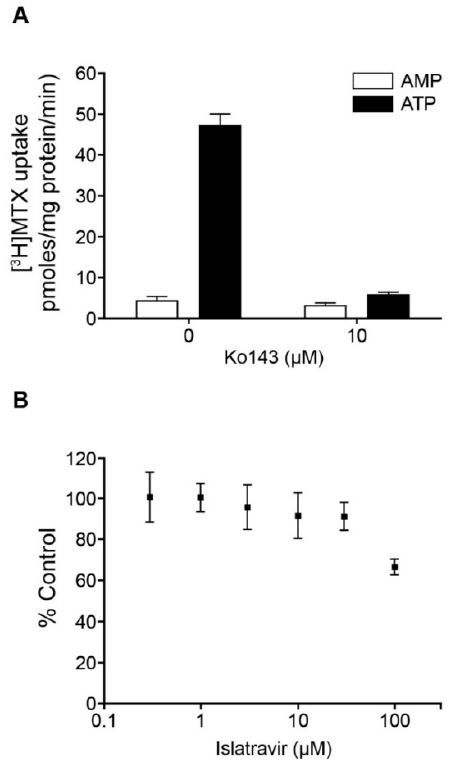
Figure 3. Inhibition of BCRP by islatravir. ( A ) Positive control, the effect of Ko143 (10 µ M) on the uptake of [ 3 H]methotrexate (MTX 10 µ M) in BCRP-containing Sf9 membrane vesicles, in the presence of ATP or AMP. ( B ) The effect of islatravir on ATP-dependent uptake of [ 3 H]methotrexate (10 µ M) in BCRP-containing Sf9 membrane vesicles (percentage of control). The experiment was per- formed in triplicate. All data are mean ± SD. AMP, adenosine monophosphate; ATP, adenosine tri- phosphate; BCRP, breast cancer resistance protein; [ 3 H]MTX, [ 3 H]methotrexate; SD, standard devi- ation.